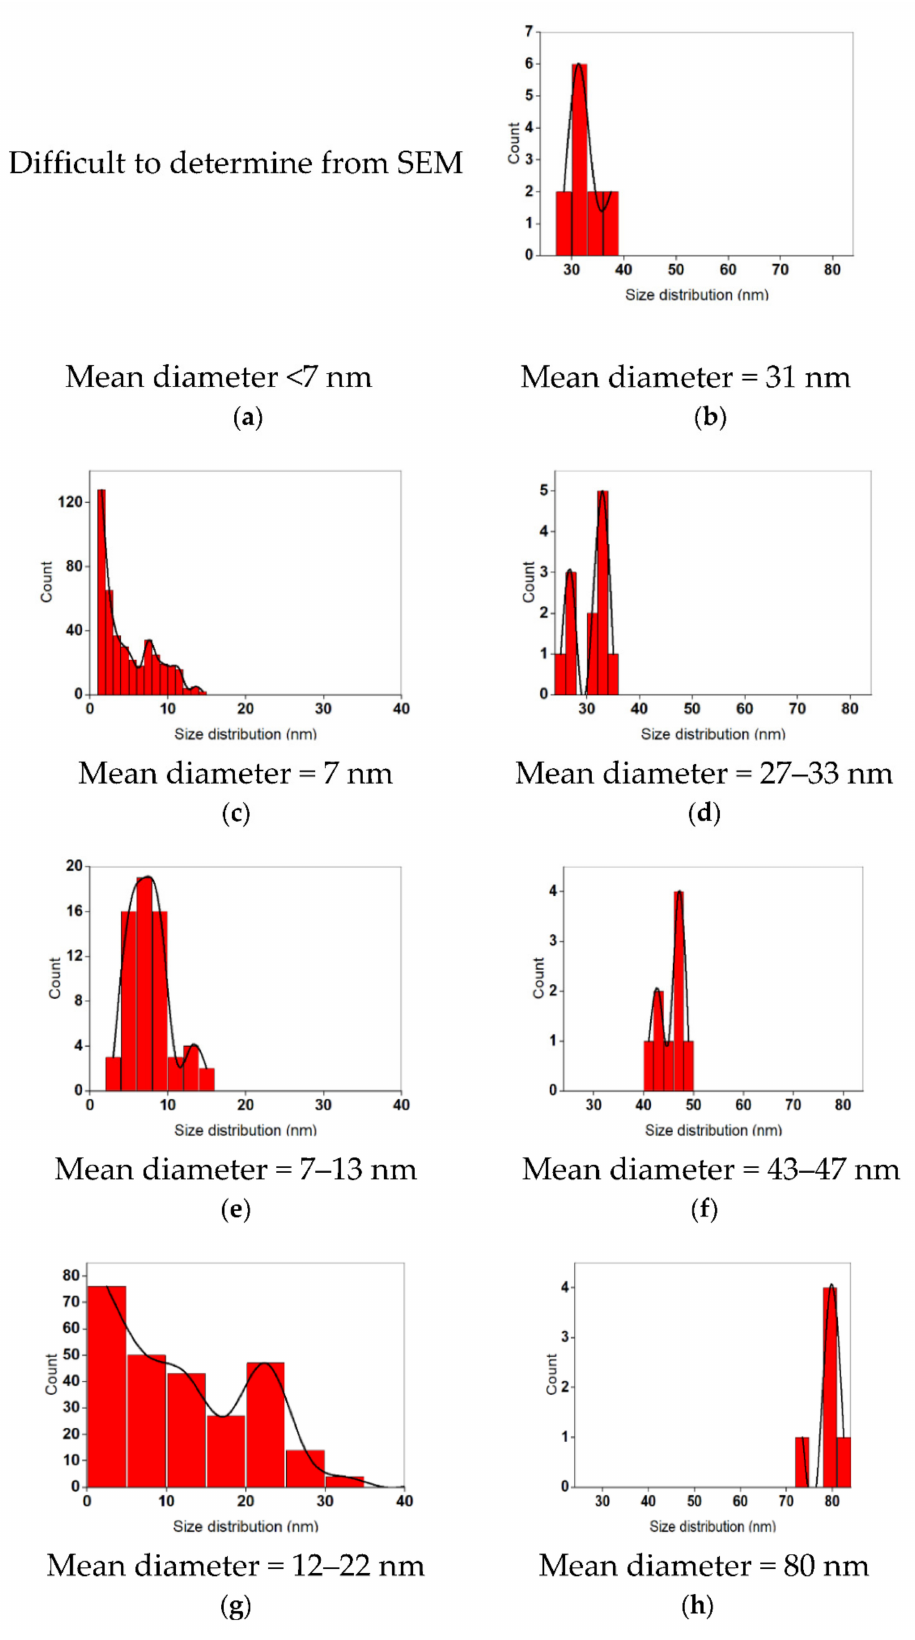
Figure A4. Size distribution histograms for the determination of average diameters (D1 and D2) of AgNPs prepared at different concentrations of Ag precursor: ( a , b ) 10; ( c , d ) 20; ( e , f ) 30; and ( g , h ) 40